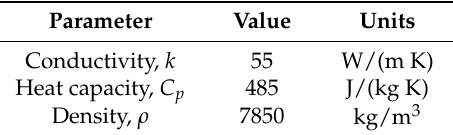
Table 7. Tool thermophysical properties.